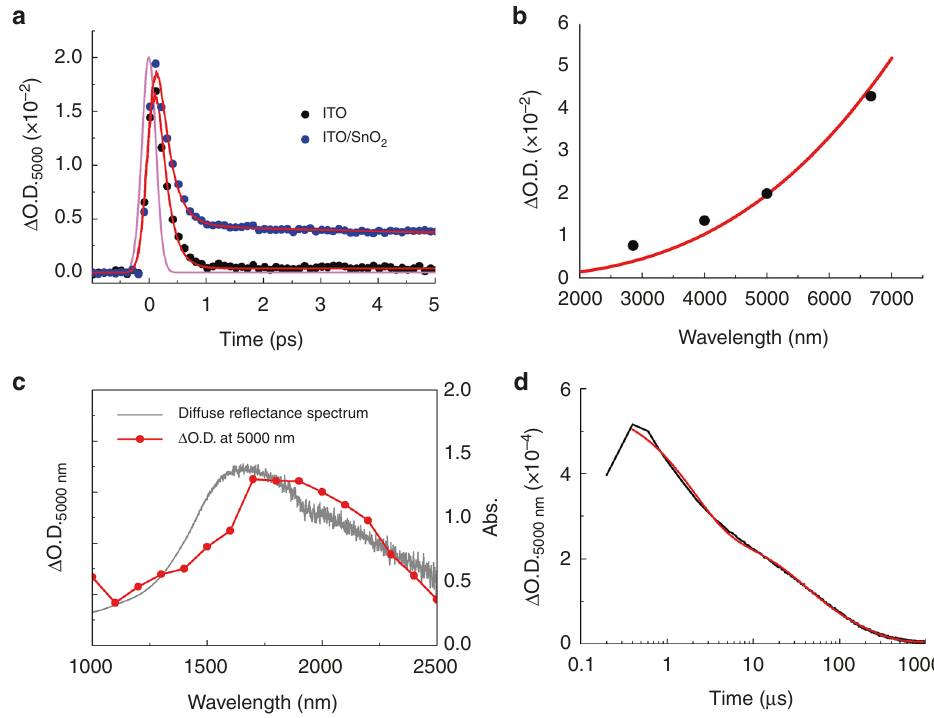
Fig. 2 TR-IR measurements and excitation spectra. a Kinetic pro fi les for the transient absorption of ITO NCs and ITO/SnO 2 at the ps scale at 5000nm upon the excitation by a 1700-nm laser. The instrument response function (IRF) (FWHM of IRF = 285 ± 40 fs) is shown by the pink line (see also Supplementary Figure 6). b TR-IR spectrum of ITO/SnO 2 at 10 ps after excitation of the LSPR band by a 1700-nm laser. The features of the observed FCA spectrum (black circles) agrees well with the absorption spectrum reproduced by simulation (red line) 15 . c Excitation spectrum for the FCA of SnO 2 . The probe light had a fi xed wavelength of 5000 nm and the excitation-light wavelength changed with the laser power kept at 6 μ J/pulse. d The kinetic pro fi le of ITO/SnO 2 at 5000 nm in the μ s region following excitation by the 1400-nm laser. (FWHM of IRF = 0.485 μ s). The red line shows the line of best fi